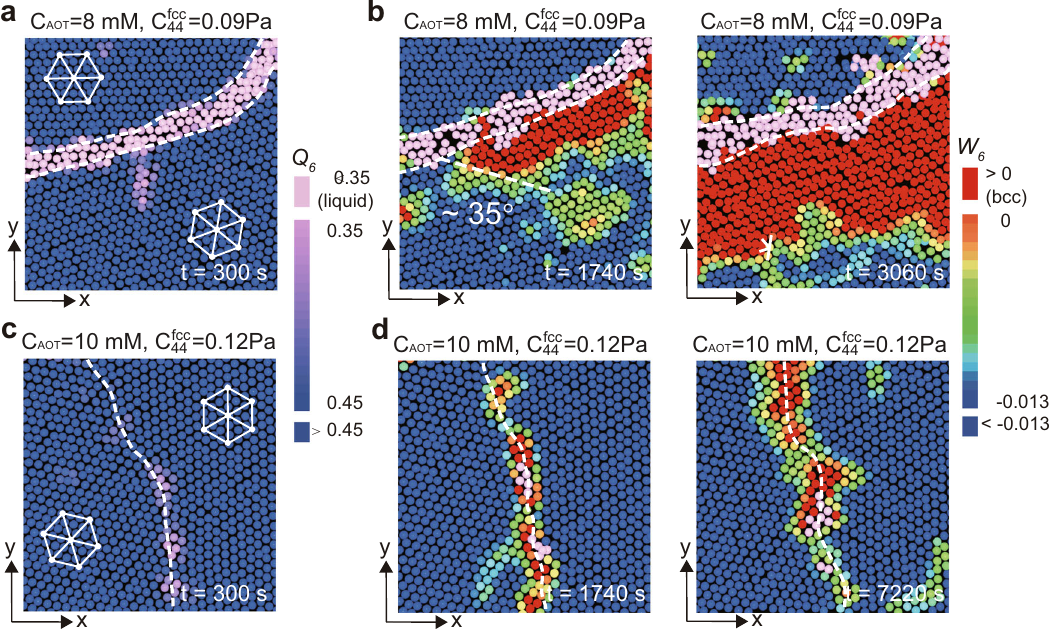
Fig. 8 The grain boundary-assisted nucleation accompanied by premelting of the grain boundary. a , b Premelting of the grain boundary ( C AOT = 8 mM, t ~ 300 s after the AOT substitution) happens for the low-modulus transition in ( a ), leading to the heterogeneous nucleation initiating from it ( C 8 mM, t ~ 1740 s and t ~ 3060 s in ( b ), respectively). Bcc solid wets the liquid with an equilibrium contact angle of about 35°. The premelting also facilitates the displacive motion of the solid. c , d The premelting behaviour is absent at C AOT = 10 mM, resulting in a small surface-energy reduction. Therefore, there is little bonus for the bcc nuclei generation and